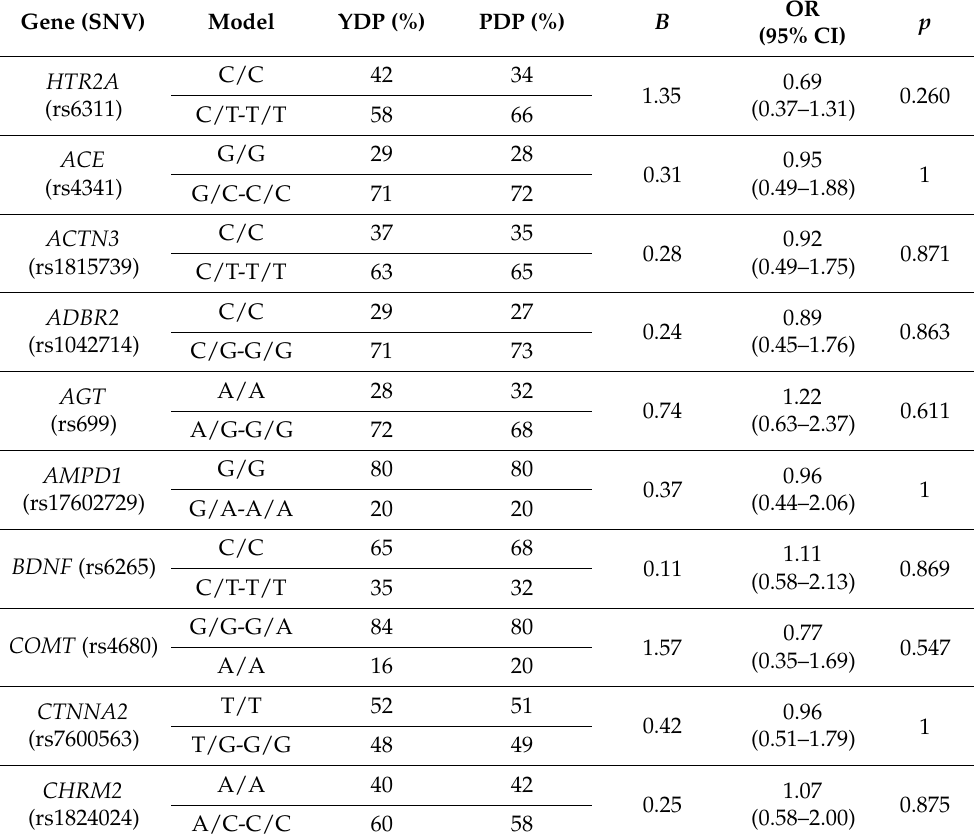
Figure 1. The IL6 (rs1800795) frequency distribution in youth development phase (YDP) and pro- fessional development phase (PDP) English academy football players. * Statistically significant at p < 0.05. Table 3. Genetic associations with youth and professional development phase English academy footballers.